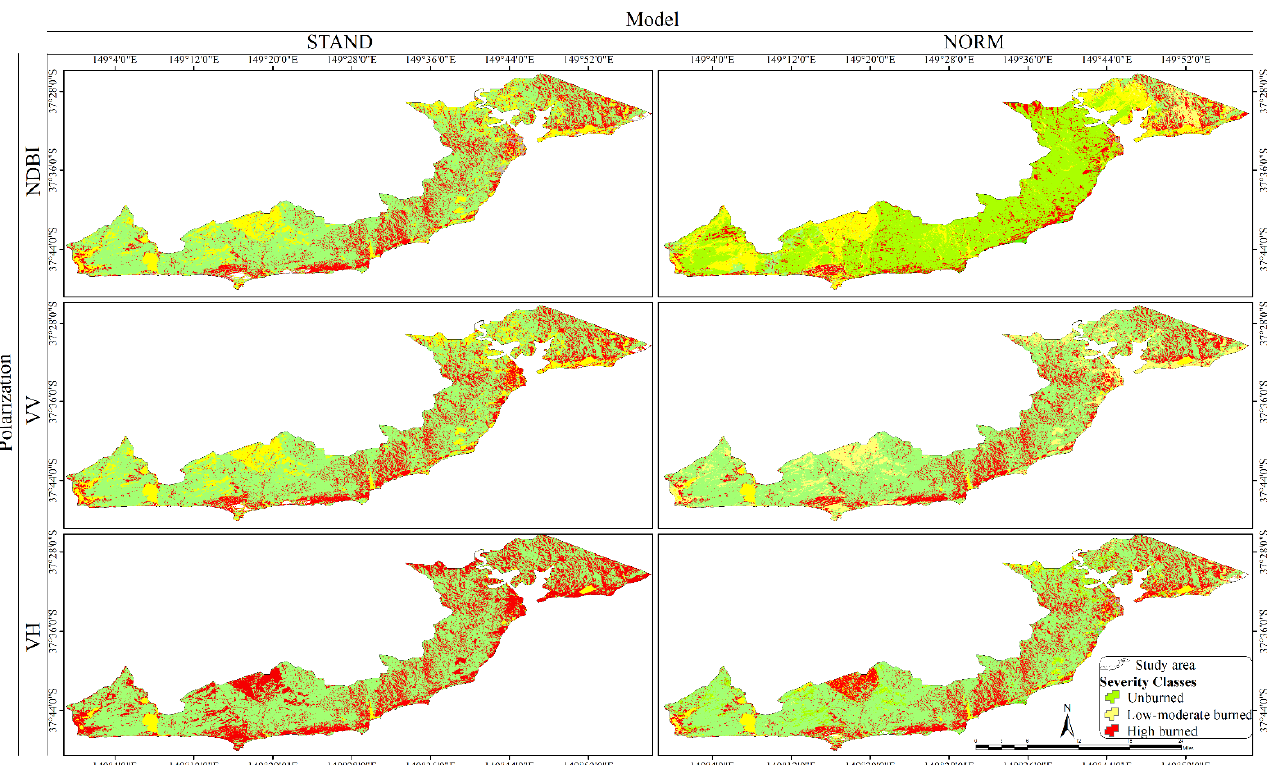
Figure A3. Wet condition.